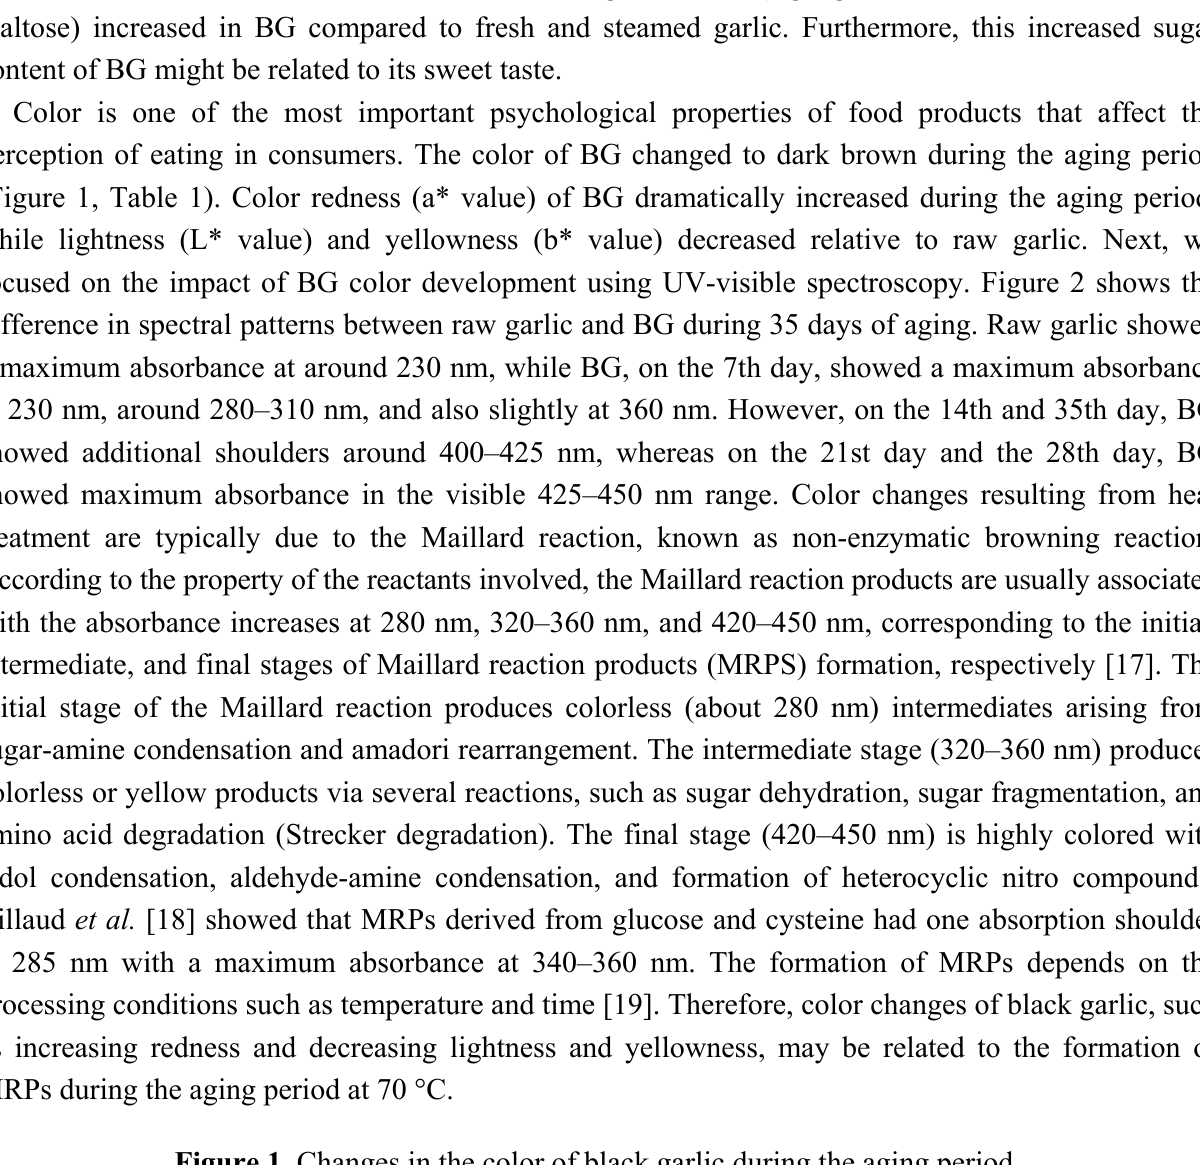
Figure 1. Changes in the color of black garlic during the aging